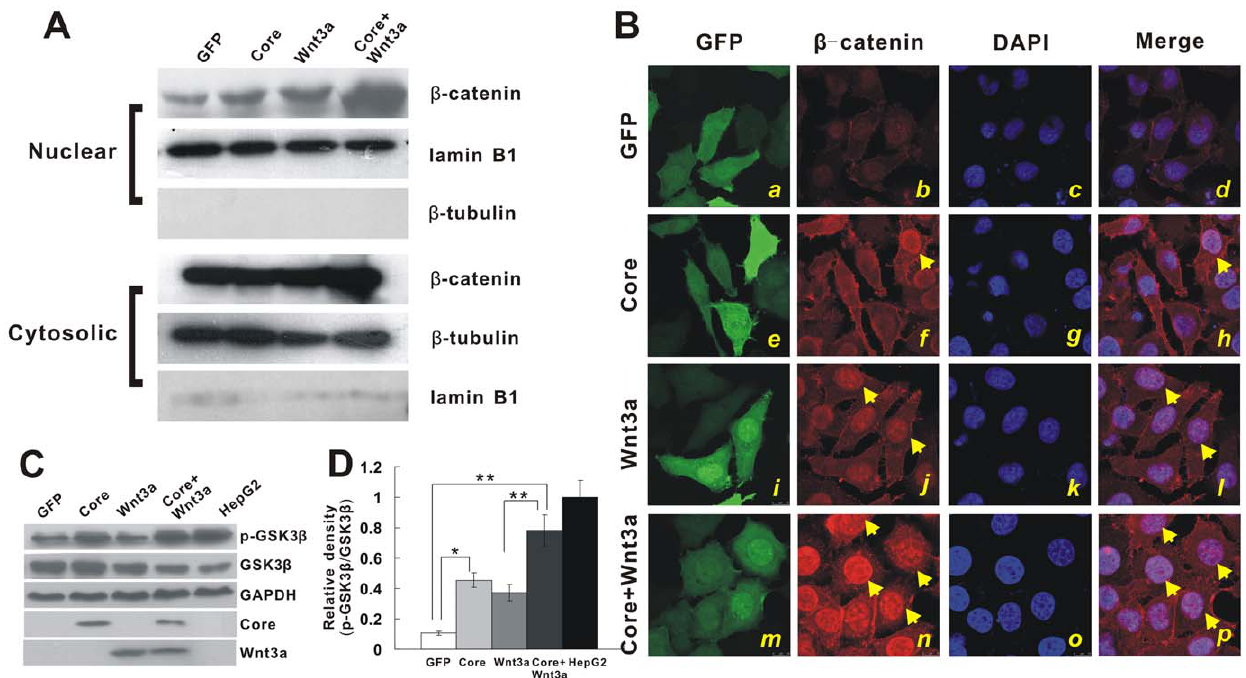
Figure 2. HCV core increases b -catenin levels in nuclear fractions through inactivation of GSK3 b in Huh7 cells. ( A ) b -catenin levels in the nuclear fractions of Ad-Core-infected Huh7 cells. Subconfluent Huh7 cells were infected with Ad-Core, AdGFP, AdWnt3A or Ad-Core plus AdWnt3A for 24 hr. Both cytosolic and nuclear fractions prepared from cells were immunoblotted with anti- b -catenin antibody. The subcellular fractions were verified by immunoblotting using either anti- b -tubulin or lamin B1 antibody. ( B ) Nuclear localization of b -catenin induced by HCV core and Wnt3A co-infection. SMMC-7721 cells were infected with AdGFP (panels a to d ), Ad-Core (panels e to h ), AdWnt3A (panels i to l ) or Ad-Core plus AdWnt3A (panels m to p ) for 24 hr. Cells were analyzed for immunofluorescence staining as described in Figure 1 . Nuclear translocation of b -catenin was indicated by yellow arrows. ( C ) Huh7 cells were infected with AdGFP, Ad-Core, AdWnt3A or Ad-Core plus AdWnt3A for 36 hr. Total cell lysate was subjected to immunoblotting with anti-phosphor-GSK3 b , anti-GSK3 b , anti-HCV core or anti-Wnt3A antibody. GAPDH was used as a loading control (bottom panel). Data were obtained from three independent experiments, and representative results are shown. ( D ) Quantitative analysis of the band intensity in Fig. 2C using the ImageJ software. * p , 0.05; ** p ,